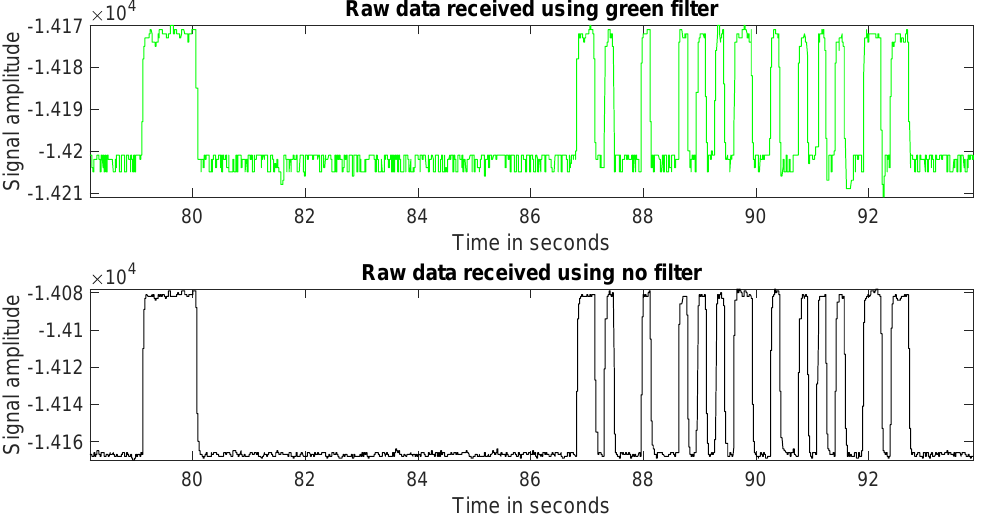
Figure 6. Sample of filtered and unfiltered signal received during Experiment